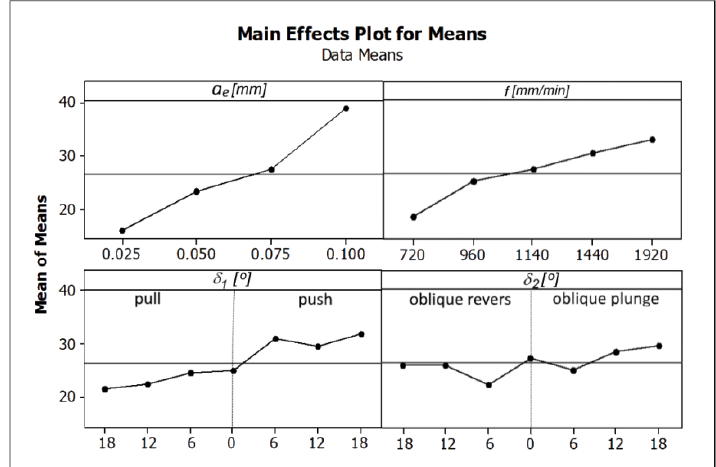
Figure 10. The influence of the analyzed factors on the calculated values of the tangential component ( F t ) of the total cutting force.